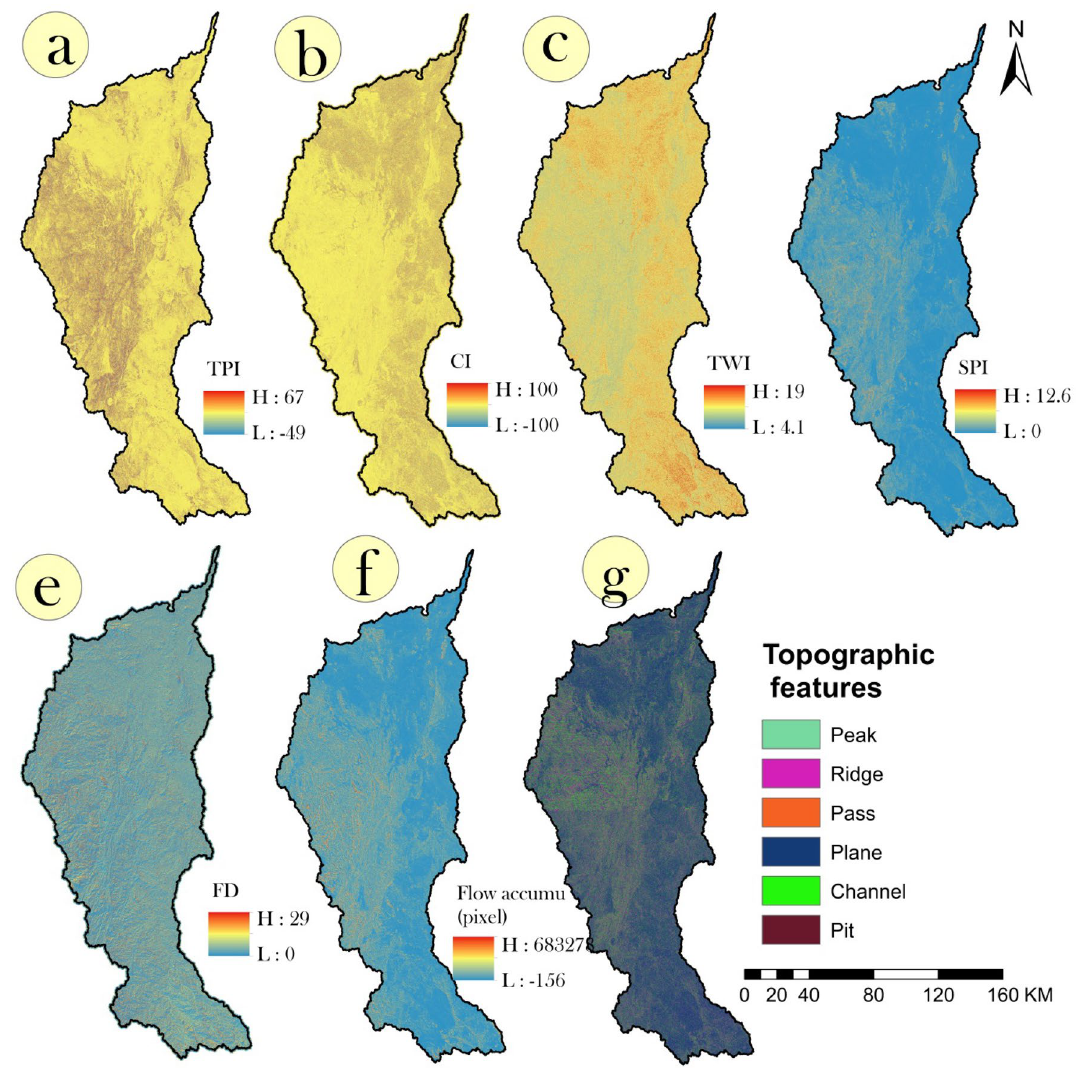
Fig. 3 DEM derived topographic and hydrologic parameters, such as a TPI, b convergence index, c TWI, d SPI, e flow direction, f flow accumu- lation, g topographic